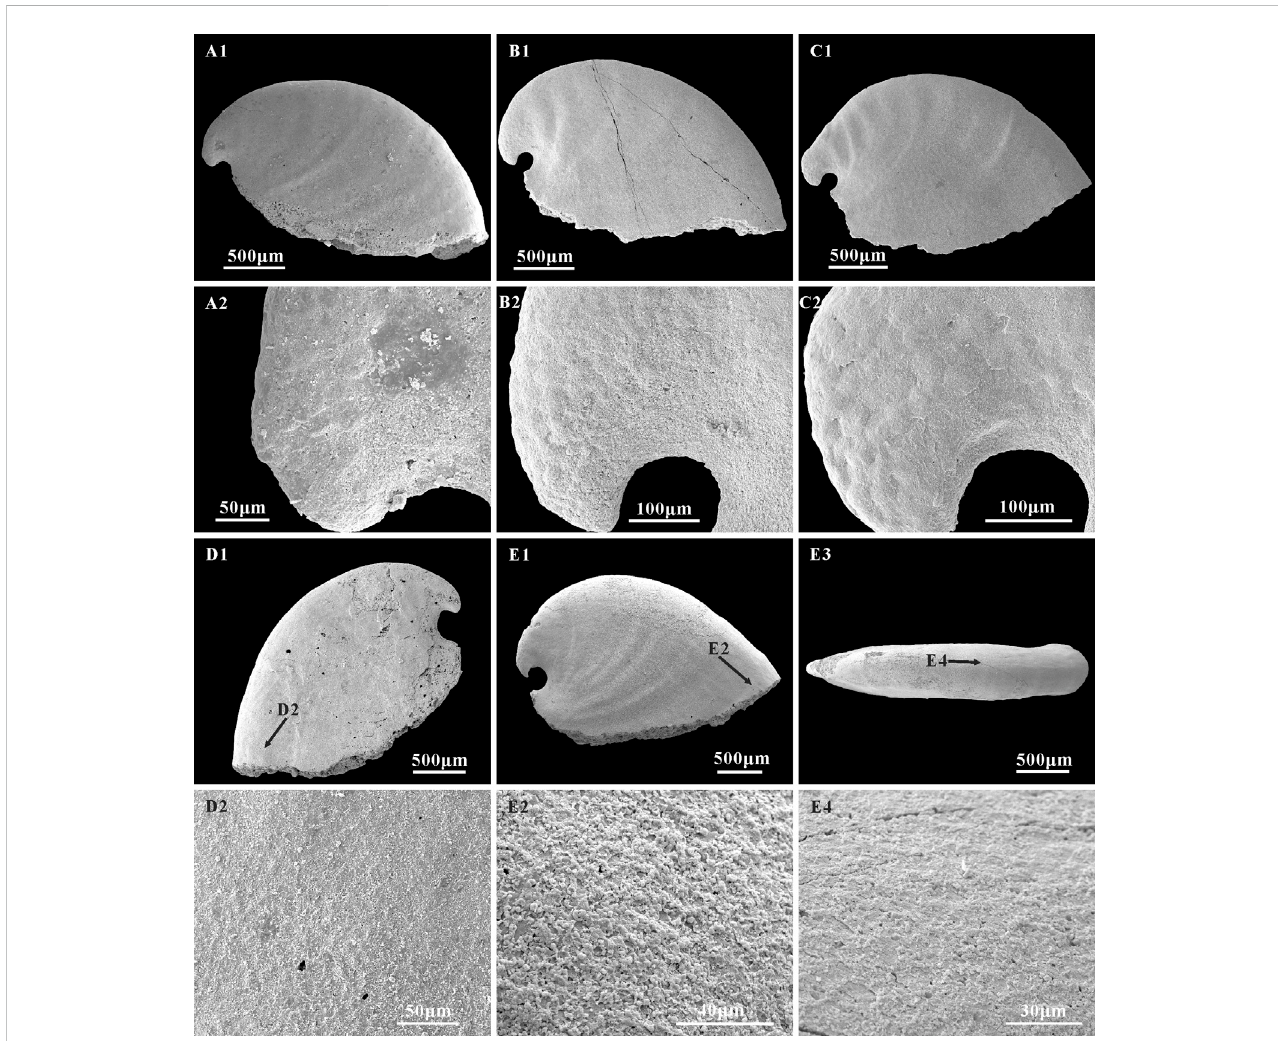
FIGURE 5 Polygonal impressions on the internal molds of A. plana . (A1,B1,C1) internal molds, lateral view, CUBar241-6, CUBar244-3, CUBar244-10, respectively; (A2,B2,C2) magni fi cations of (A1,B1,C1) , showing the convex polygonal impressions on the apical area, represent the cell imprints of the outer